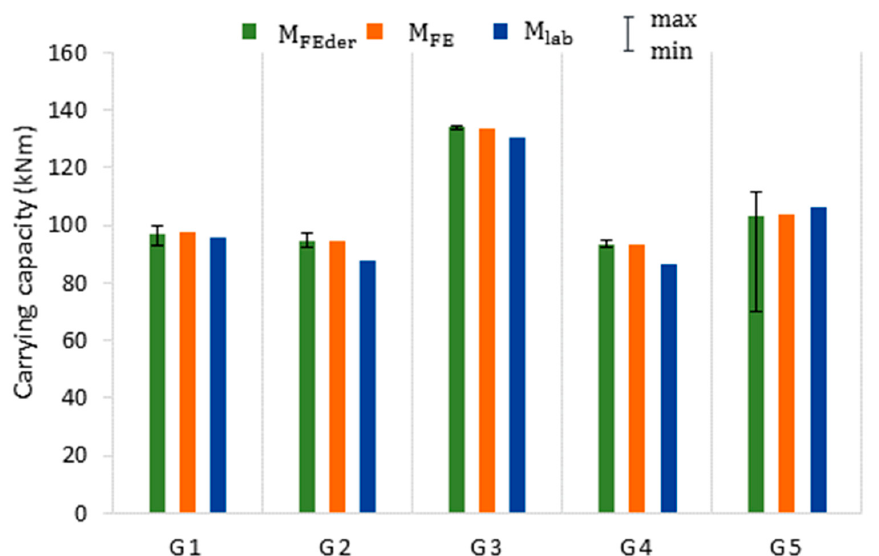
Figure 16. Ultimate moment capacity of laboratory ( blue ) and numerical ( orange ) experiments on original beams and numerical experiments on derived beams ( green ). The whiskers show maximum and minimum moment capacities for derived beams.